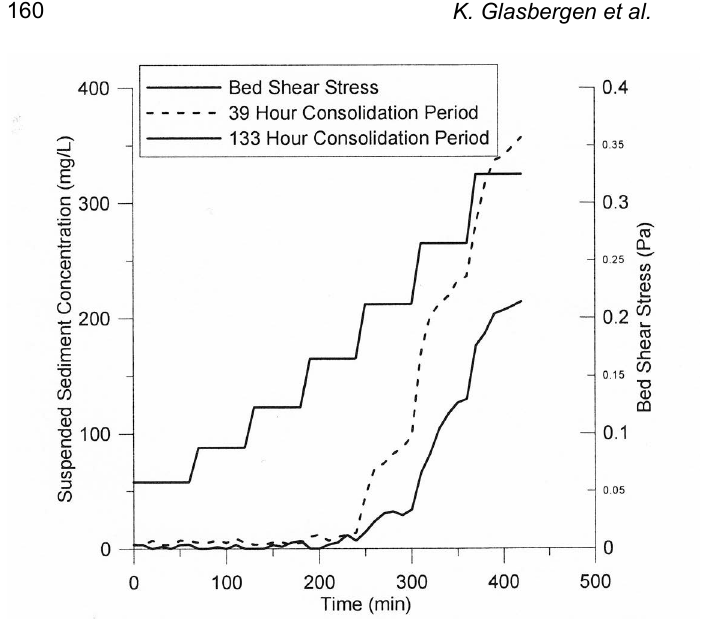
Fig. 2 Cohesive sediment bed erosion for 39 h and 113 h consolidation periods.